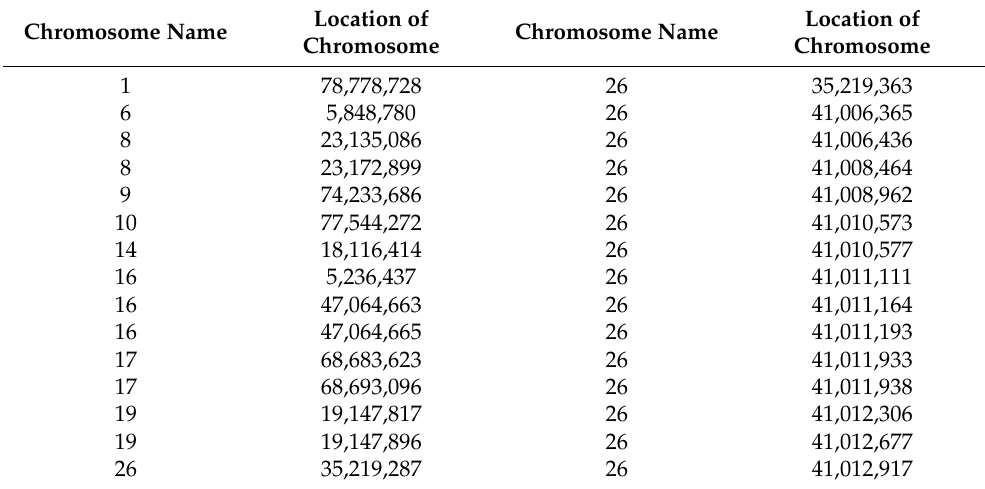
Table A2. Thirty common population-specific SNP genotype locations in goats of all groups.